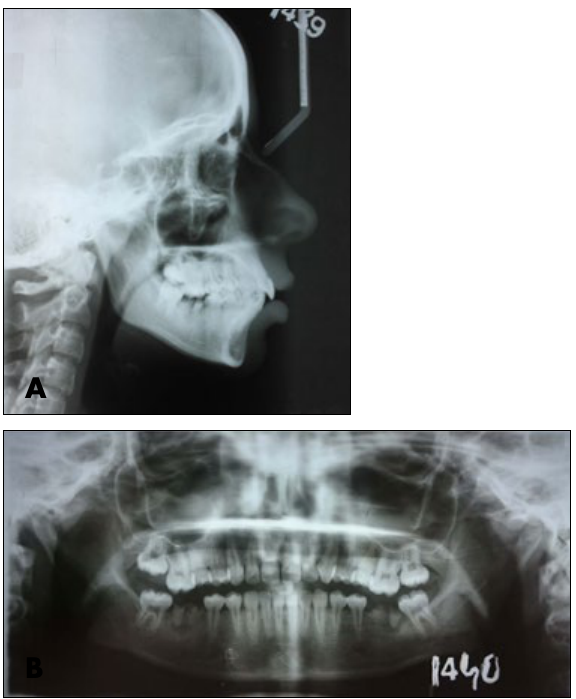
Figure 3 (a, b). Pretreatment lateral cephalogram and